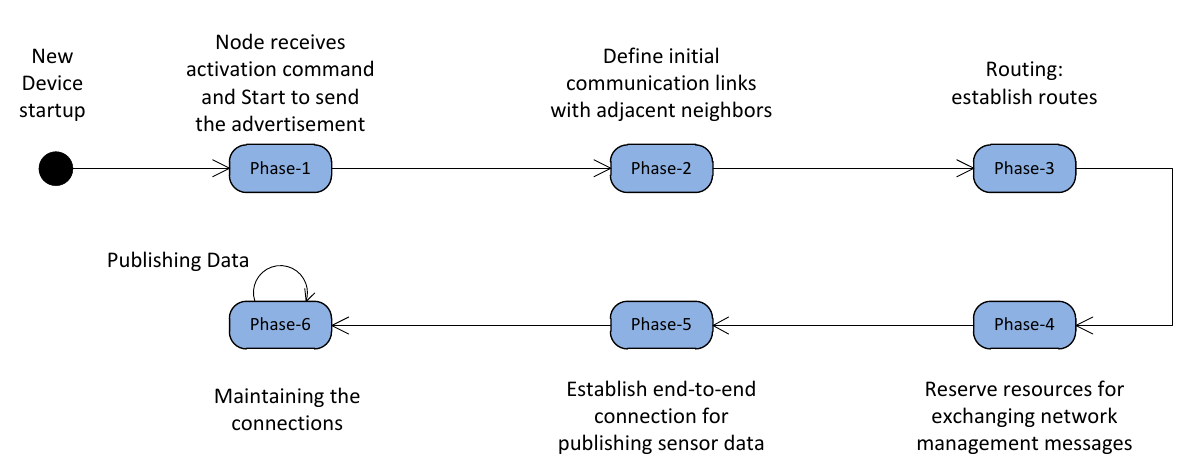
Figure 11. Different states of a node operation in the